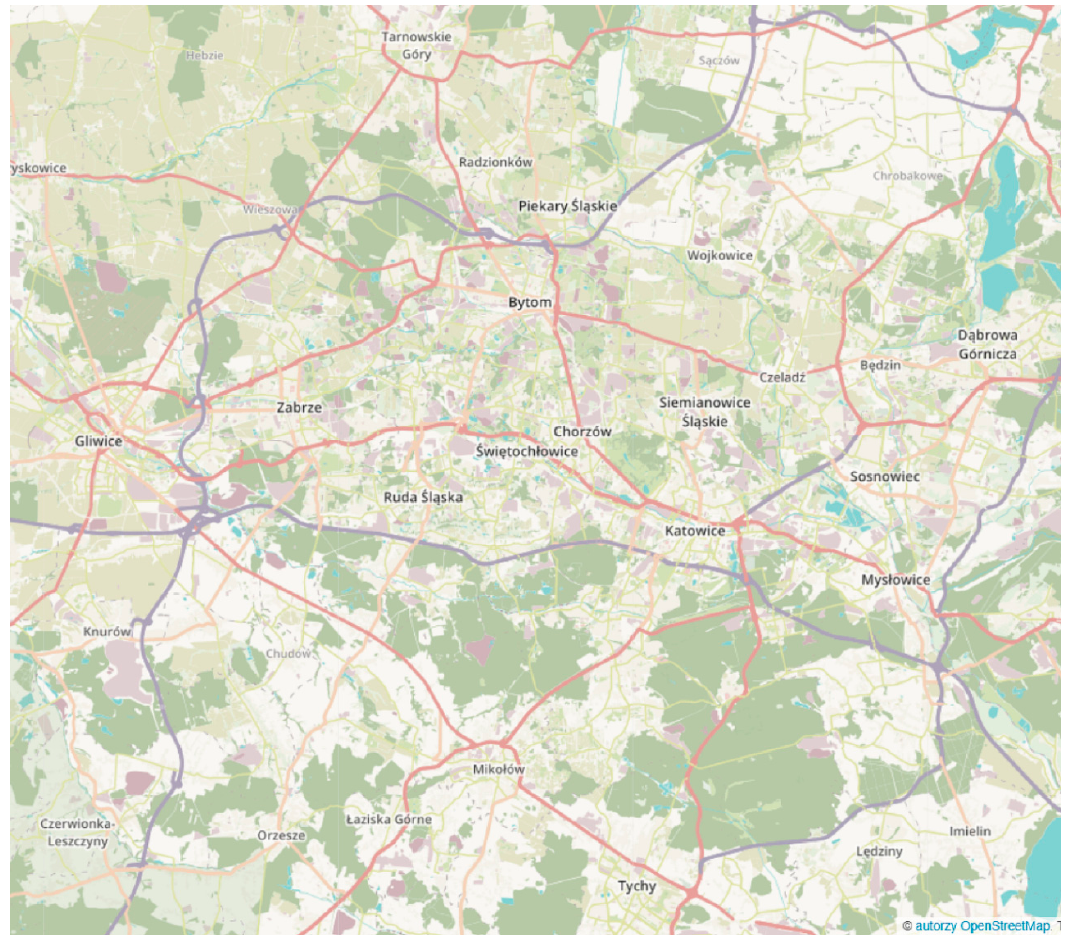
Figure 1. Map of considered area (OpenStreetMap). Table 1. The main cities of Upper Silesia region.